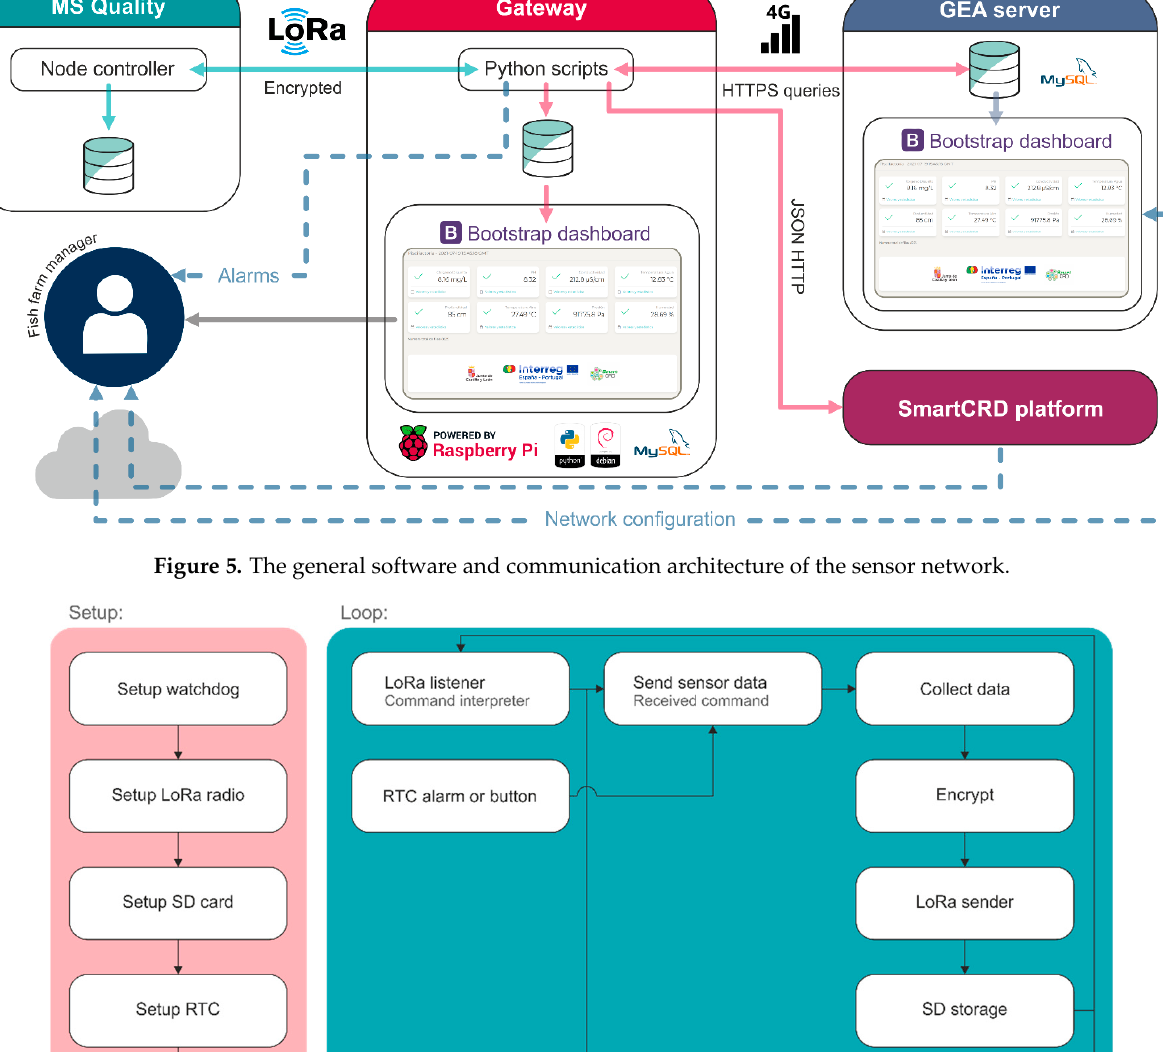
Figure 5. The general software and communication architecture of the sensor network.